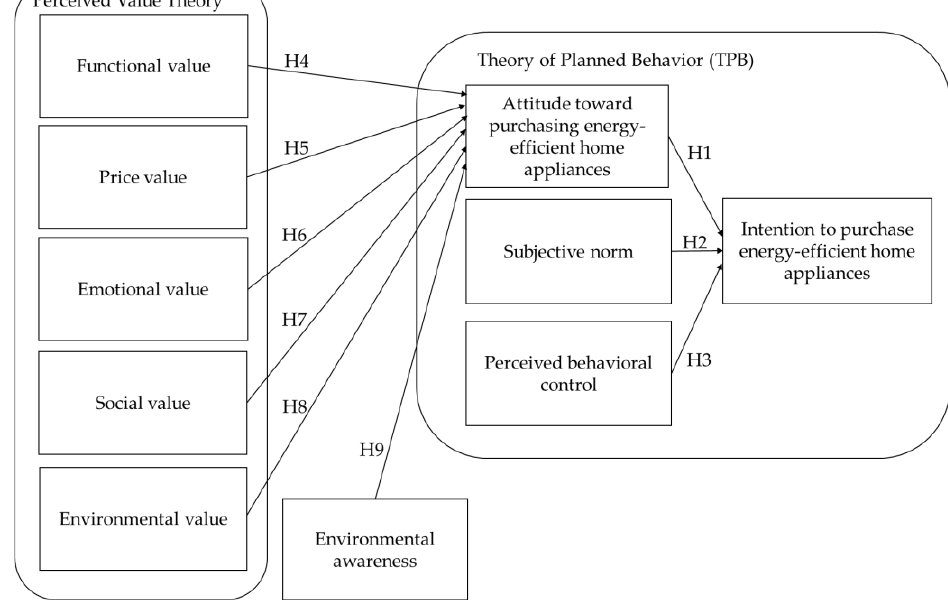
Figure 1. Theoretical research Figure 1